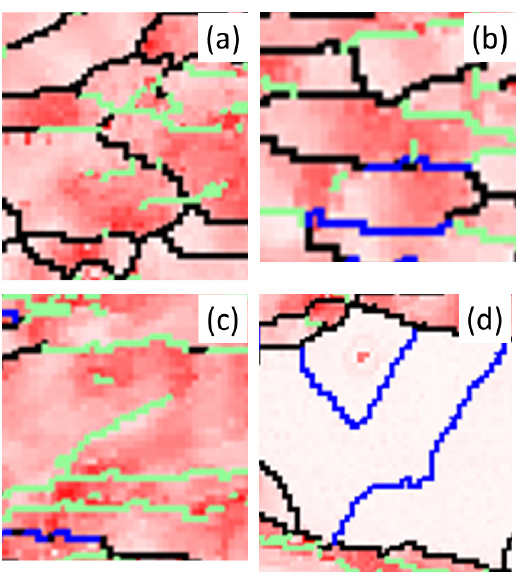
Figure 11. Magnification image of ( a ) A area with LAGBs; ( b ) B area with HAGB and LAGB; ( c ) C area with HAGB and CSL; and ( d ) D area with CSLs for 90% cold-rolled FePd alloy at 700 °C after 1 min. A, B,C and D symbols indicate the areas of image magnification marked in white dash lines in Figure